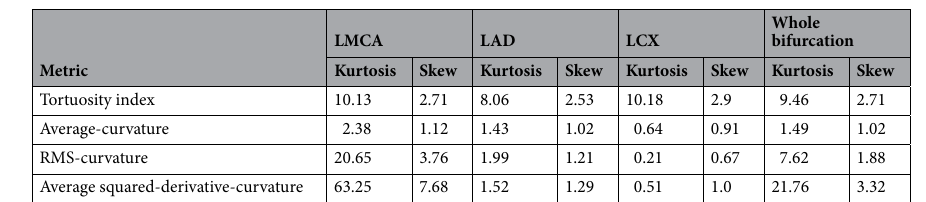
Table 3. Kurtosis and skewness of tortuosity metrics studied in 127 left main bifurcations and LAD and LCx branches.